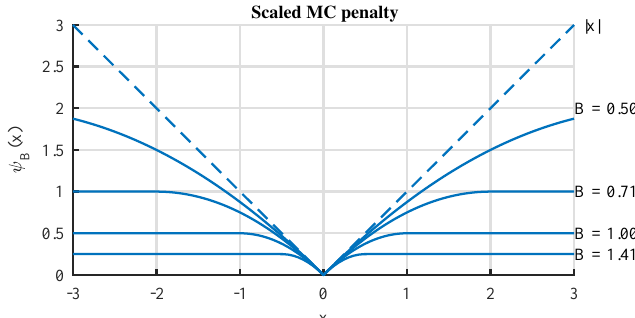
Figure 2. Illustration of the generalized minimax concave (GMC) penalty